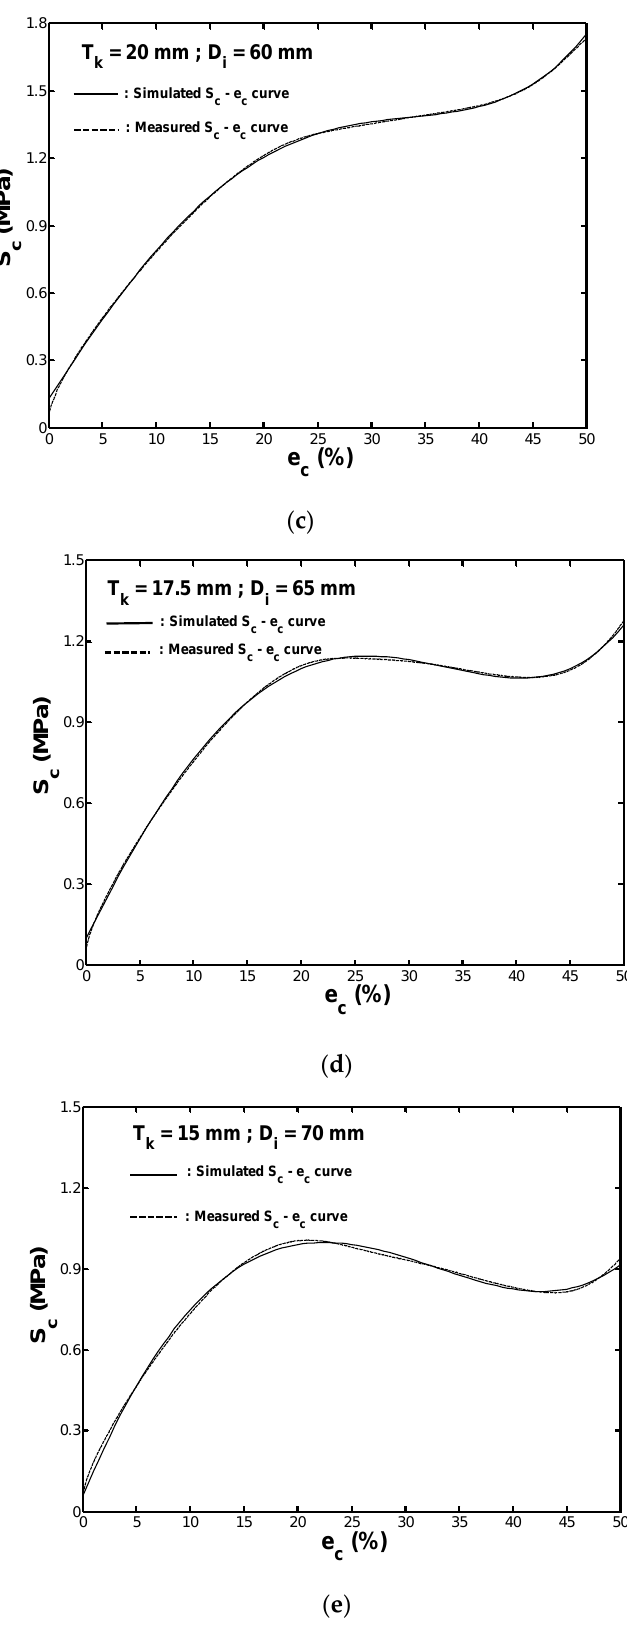
Figure 8. Comparison of the measured 𝑆 𝑐 − 𝑒 𝑐 curves and simulated ones under monotonic compression loading for fenders with wall thicknesses of: ( a ) 25.0 mm, ( b ) 22.5 mm, ( c ) 20.0 mm, ( d ) 17.5, and ( e ) 15.0 mm.